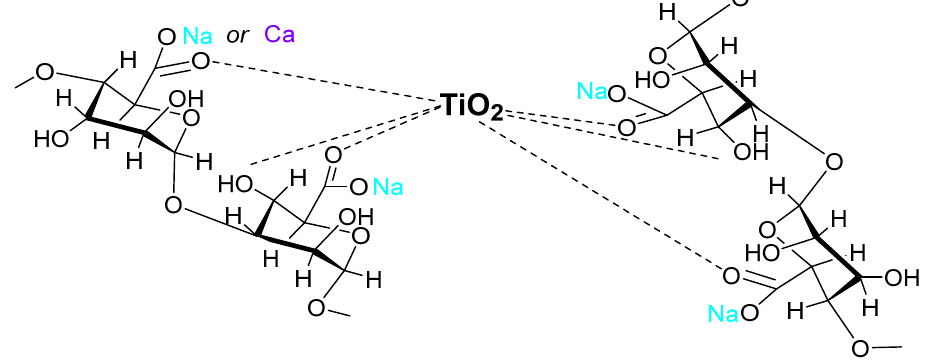
Figure 5. Possible binding mechanism of sodium or calcium alginate with TiO 2 .